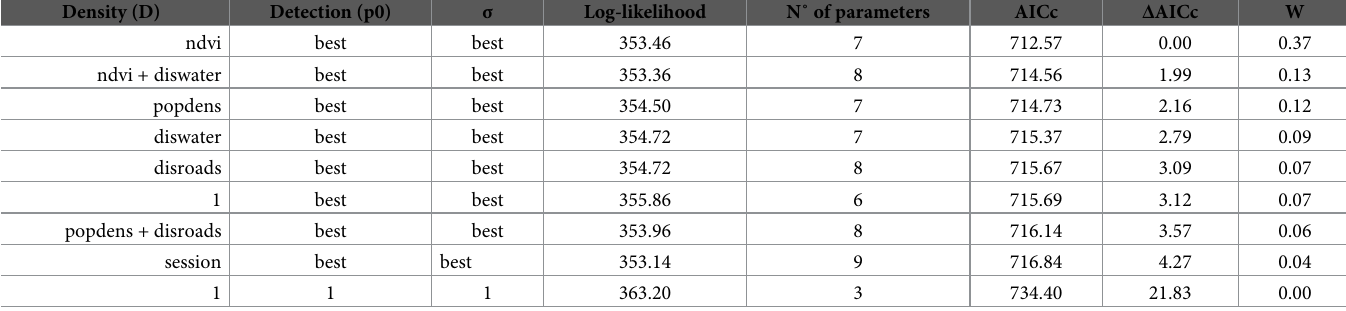
Table 4. Candidate models evaluating the role of covariates on margay density ( D ) ( σ : Spatial scale, AICc: Akaike Information Criteria for small sample sizes; Δ AICc: Difference between AICc of each model and the model with the lowest AICc; w: Weight). Density (D) Detection (p0)